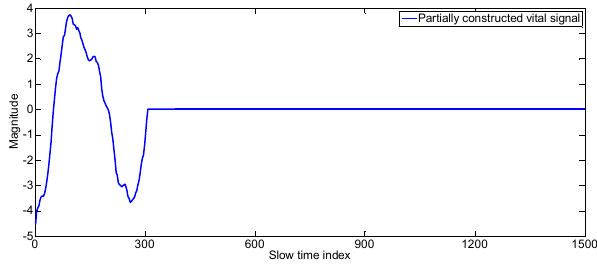
Figure 9. The constructed vital signal after second iteration.